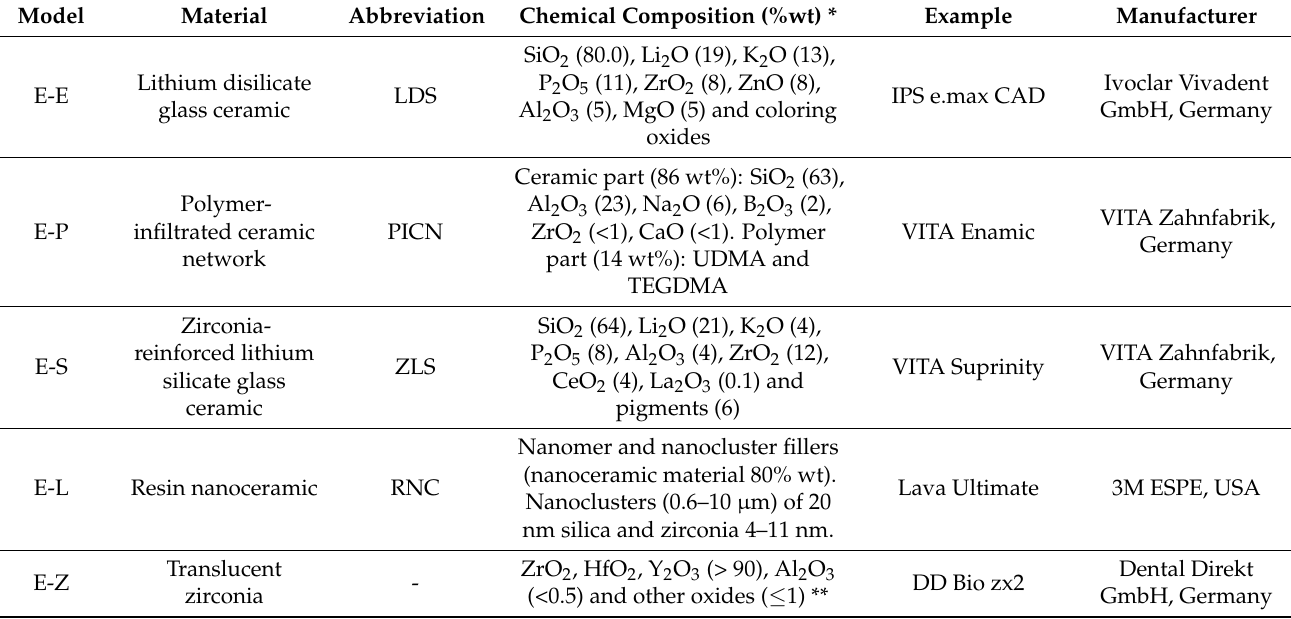
Table 1. The models and their materials.